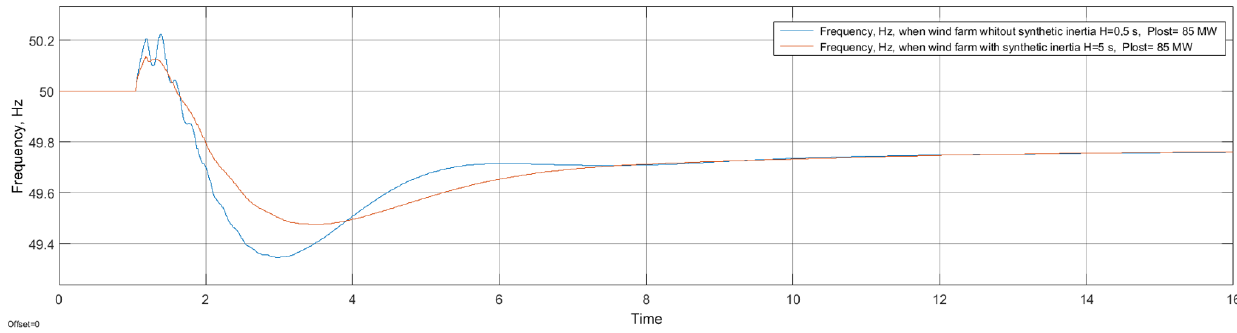
Figure 10. Single-line diagram of a system with a generating power source with the SI algorithm connected to 1212 busbars.